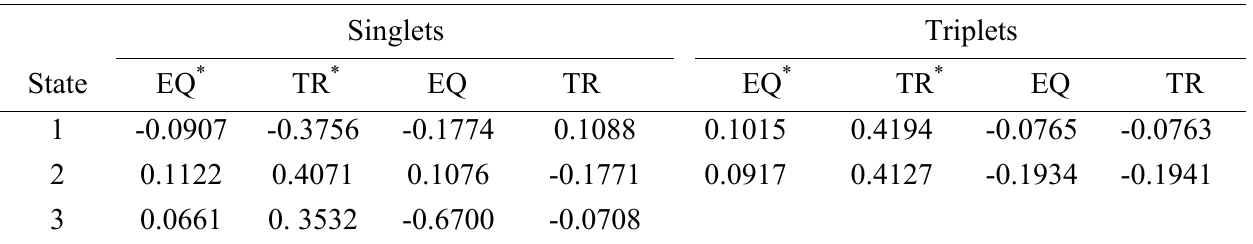
Table 2. Mulliken proton charges for standard equilibrium (EQ) and middle (TR) hydrogen bond proton positions of malonaldehyde within the Sadlej [14] basis set in the case of the lowest singlet and triplet electronic